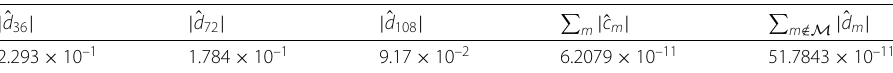
(cid:15) |ˆ d m m / ∈ M